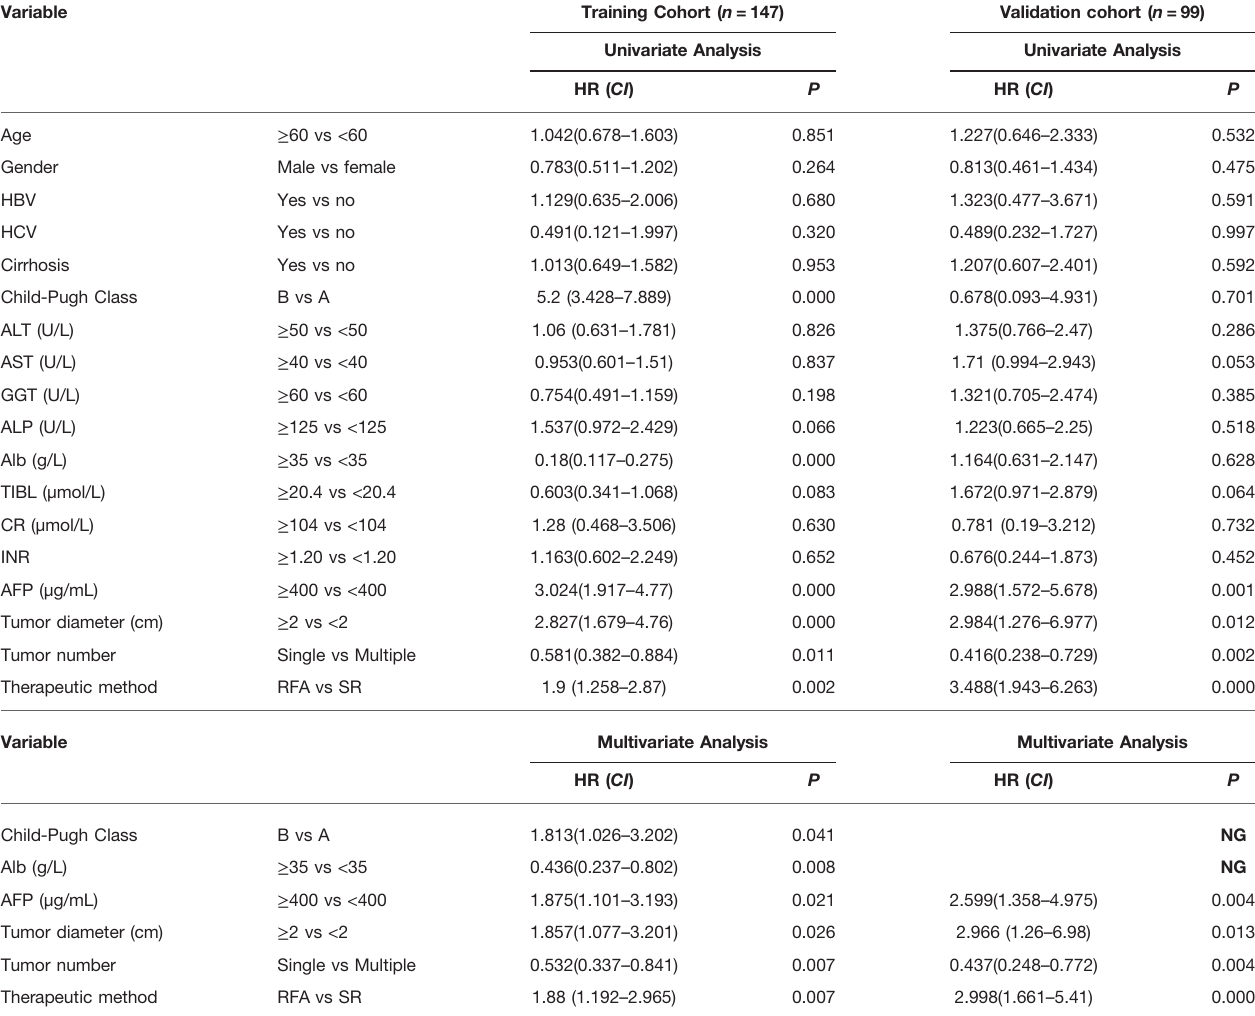
TABLE 4 | Univariate and multivariate analysis to identify independent risk factors of OS in CTC-positive HCC.